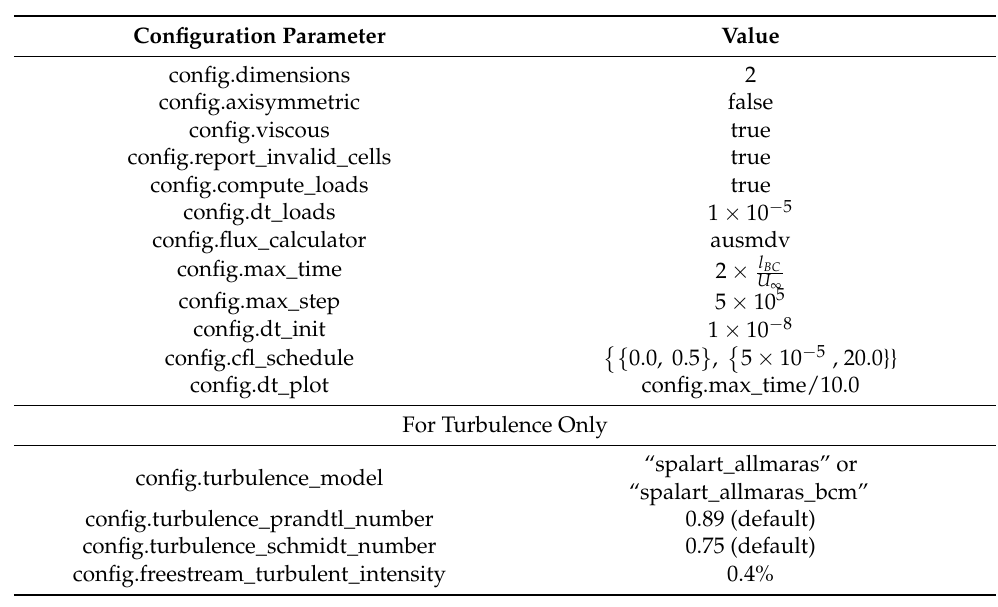
Table 4. Details of the configuration in flat-plate Lua